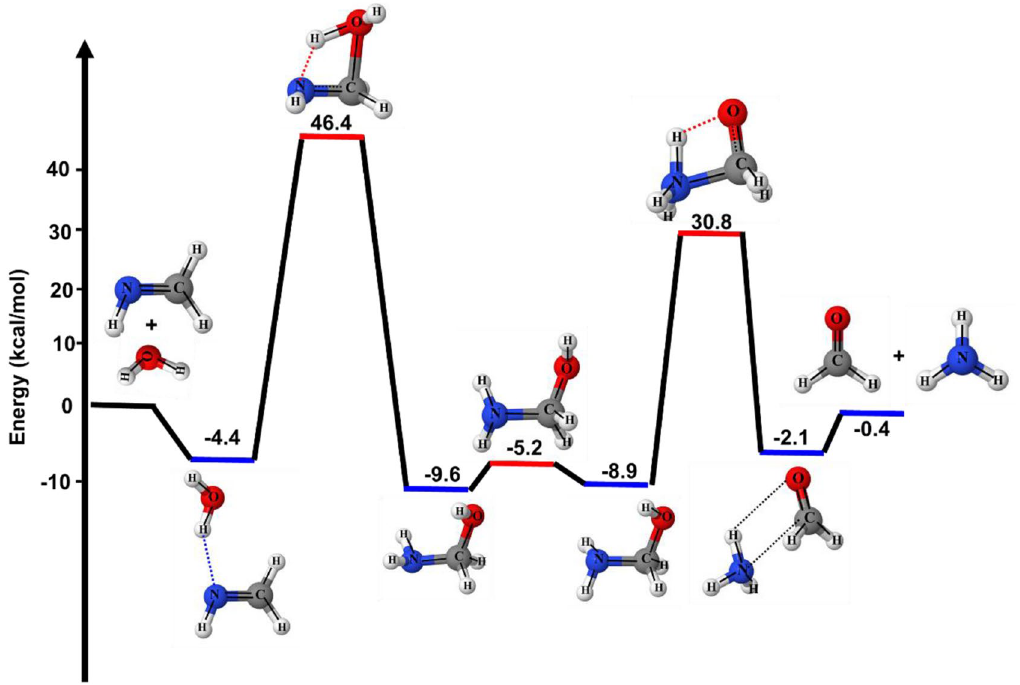
Figure 1. The stationary points on the PES for CH 2 NH + H 2 O reaction were obtained using CCSD(T)/6– 311++G(3df,3pd)//M06-2X/6–311++G(3df,3pd). The relative energies include ZPE corrections are relative to CH 2 NH + H 2